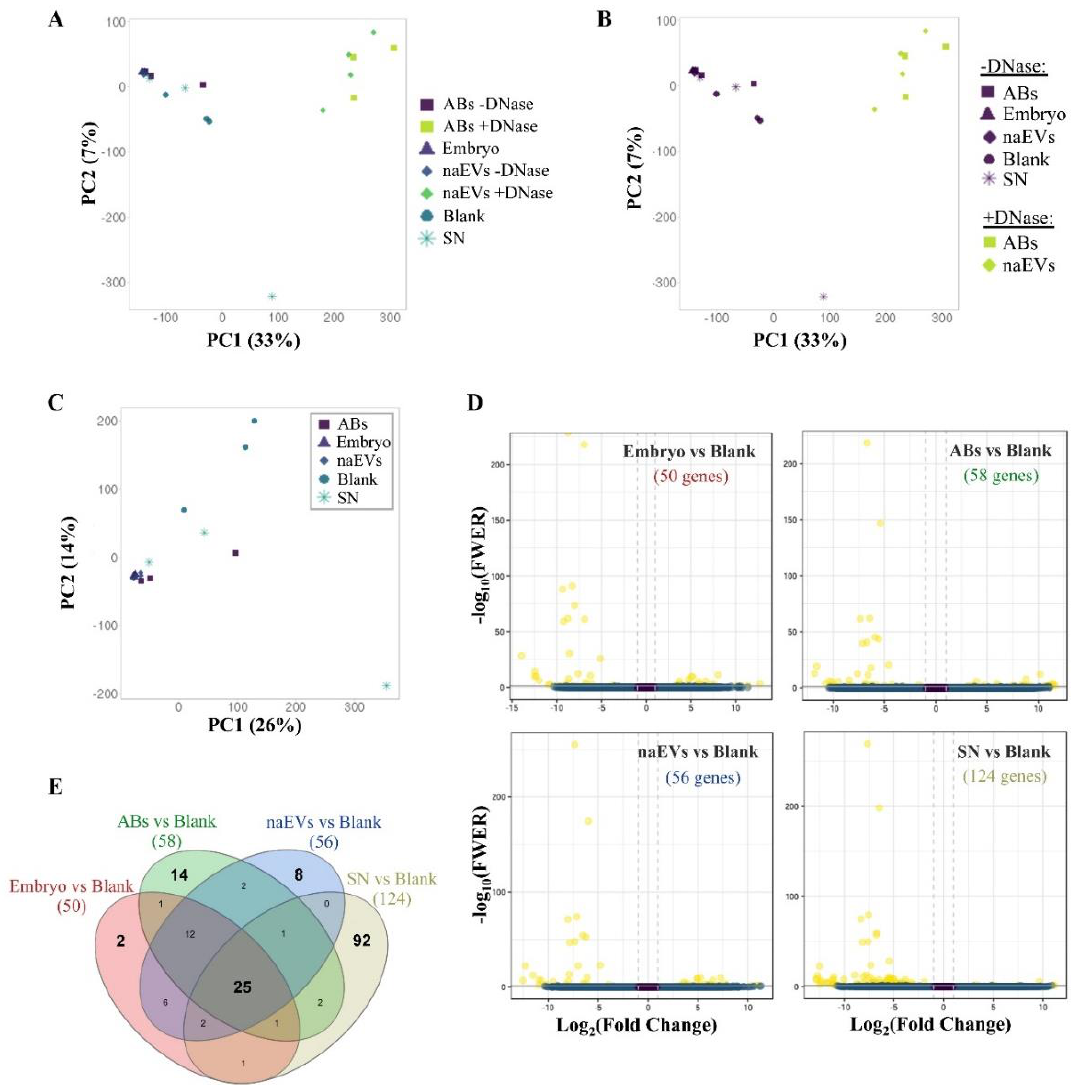
Figure 5. Analysis of murine-specific DNA sequences secreted by the embryo to the culture media. Study of DNA sequences uniquely mapping to Mus musculus reference genome secreted by the murine embryo to the spent media in EVs or as a free form. ( A ) PCA showing similarity between samples using normalized counts of 27,970 genomic features after filtering out human-homologous reads. ( B ) PCA grouping samples by DNase treatment. ( C ) Separate PCA of DNase untreated samples using normalized counts of 27,824 genomic features after filtering out human-homologous reads. ( D ) Volcano plots showing di ff erential enriched genes in the studied fractions (embryo, ABs, naEVs, or SN) compared to the blank control. Negative FC values (left) indicate genes that are enriched in each fraction with respect to the blank medium, while positive values (right) correspond to genes enriched in the blank medium compared to the studied sample. The number of di ff erentially enriched genes is shown in brackets for each comparison. ( E ) Venn diagram showing common and specific enriched genes in pairwise comparisons. Abbreviations: AB, apoptotic bodies; naEVs, smaller in size extracellular vesicles (including microvesicles and exosomes); SN,